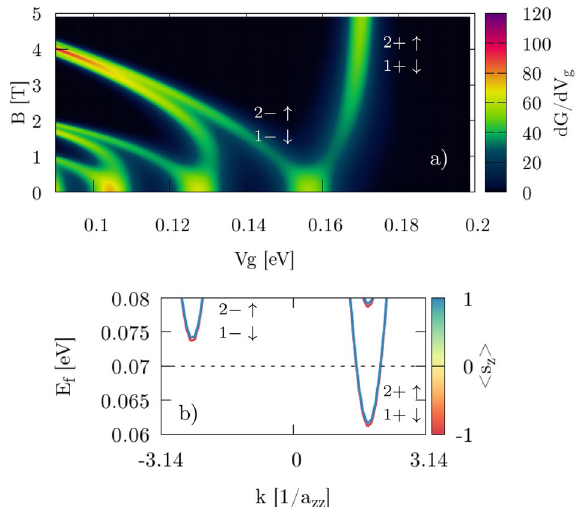
orientation of the magnetic field with NO SOI. ⊥ ) and down ( ). Smooth ↑ ↓